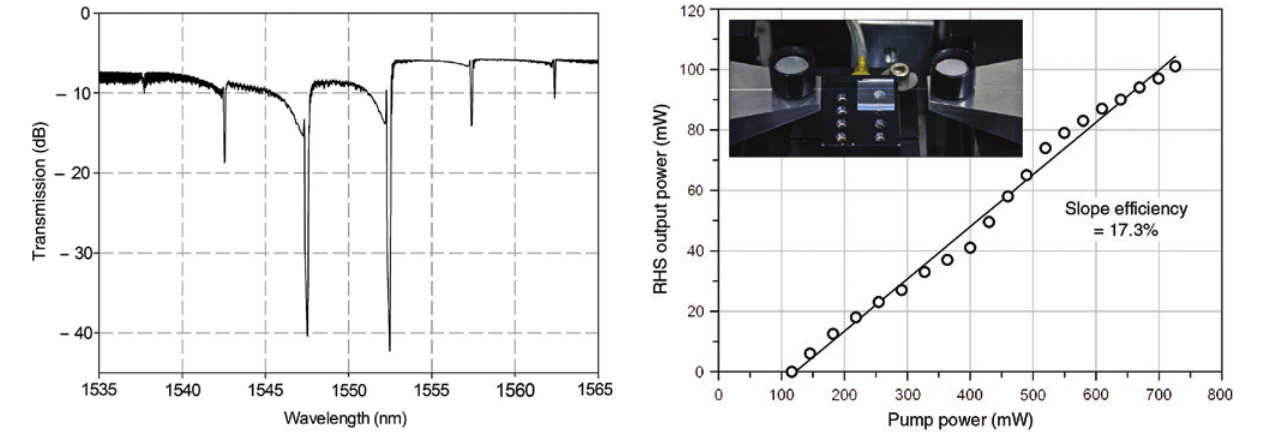
Figure 20: DFB WGL at 1032 nm fabricated in a 9% Yb-doped phos- phate glass